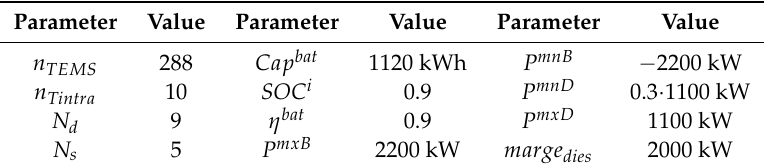
Table 1. Parameters for the EMS optimization